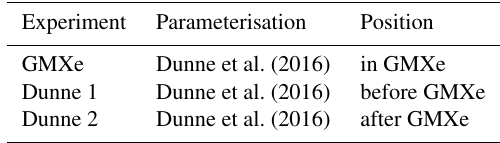
Table 1. Overview of the EMAC simulations. The chemistry was taken from Jöckel et al. (2016). The column “experiment” gives the name of the experiment, which is used for axis labelling in figures. Column “parameterisation” gives the citation for the nucleation pa- rameterisation used. “Position” in EMAC indicates in which part of the code the nucleation rate was calculated. Experiment Parameterisation Position GMXe Dunne et al. (2016) in GMXe Dunne 1 after GMXe